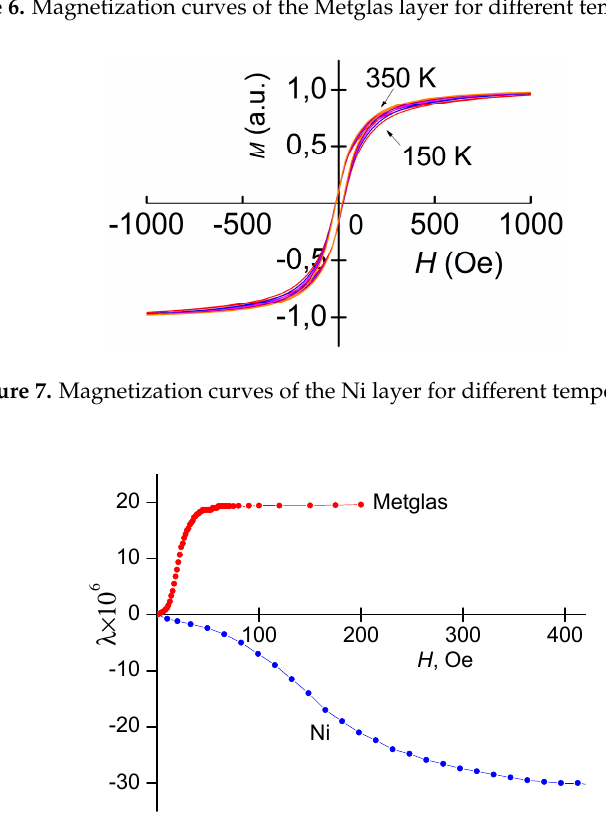
Figure 8. Dependences of magnetostriction λ for Metglas and Ni slabs on magnetic field H at room temperature.